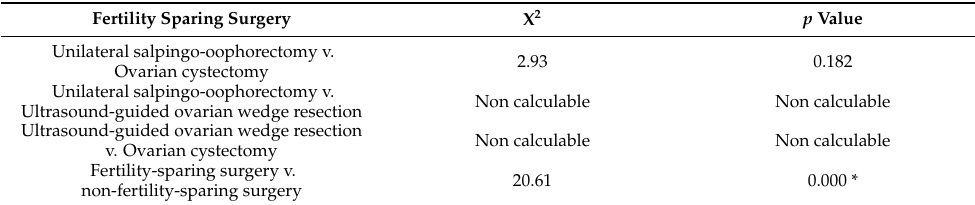
Table 5. Comparisons between types of fertility-sparing surgery and recurrence of Borderline Ovarian Tumour.